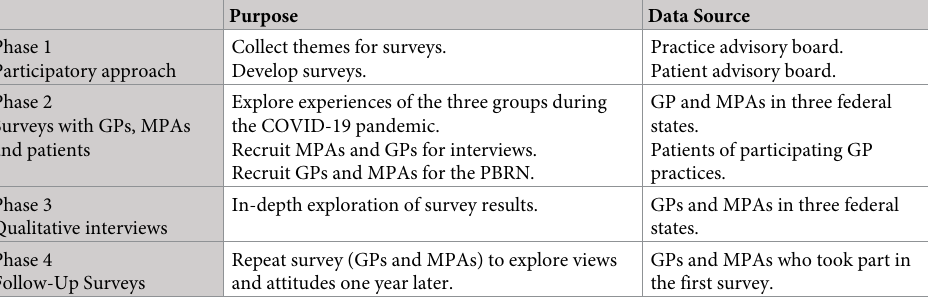
Table 2. Study structure: Purpose and data